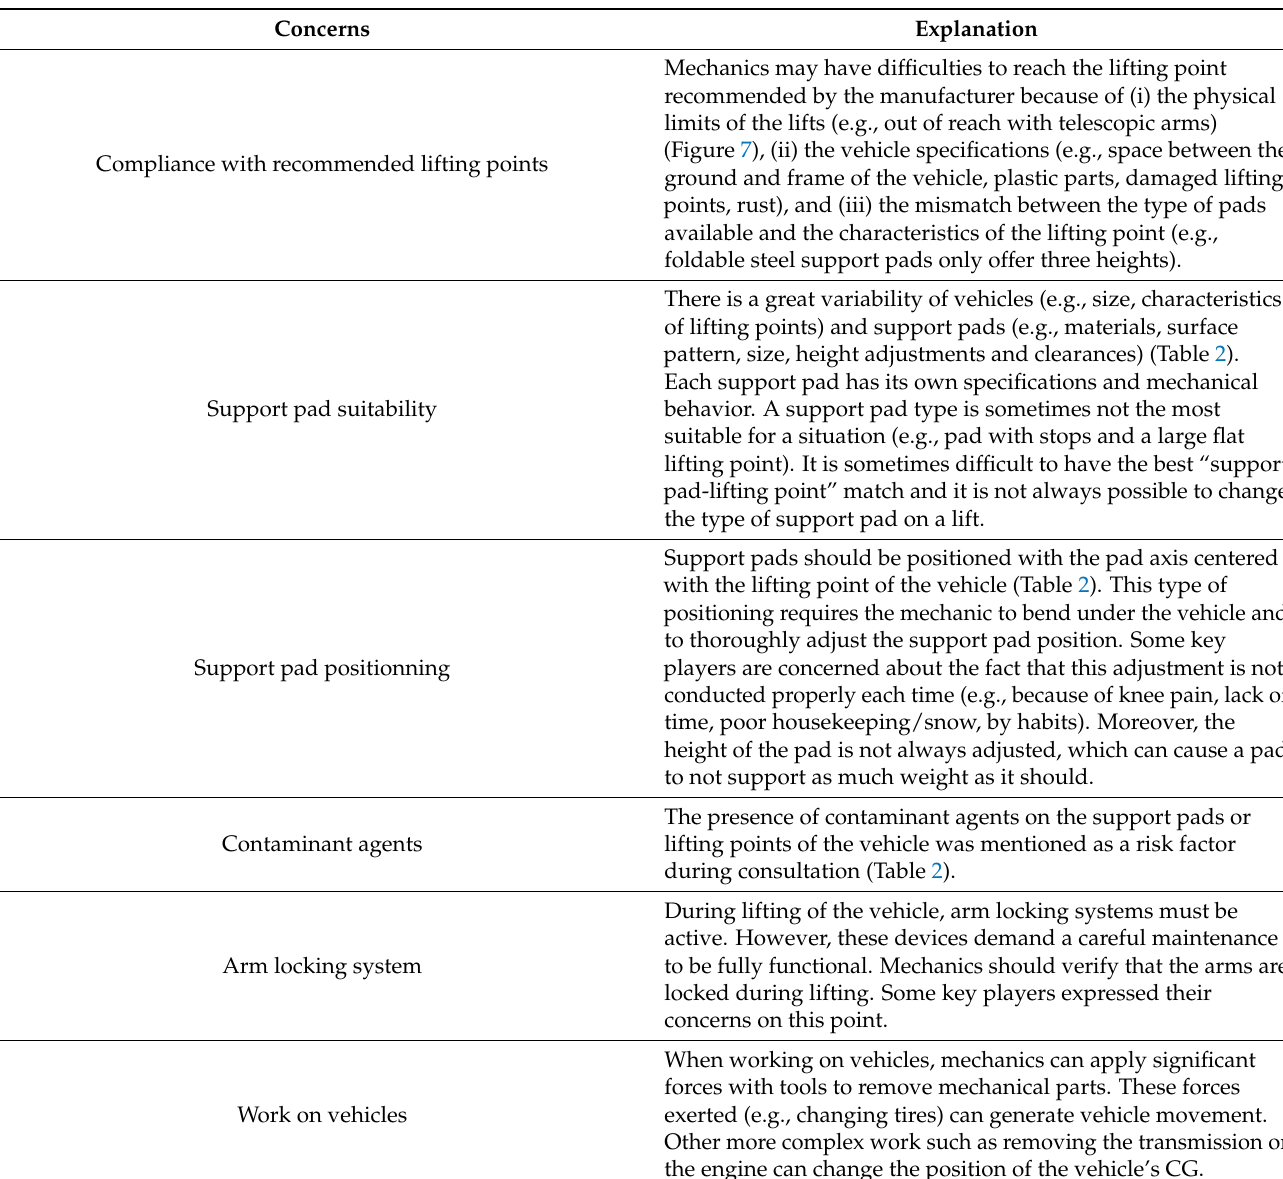
Table 5. Concerns reported by key players on the use of support pad on 2PAG lift regarding safety